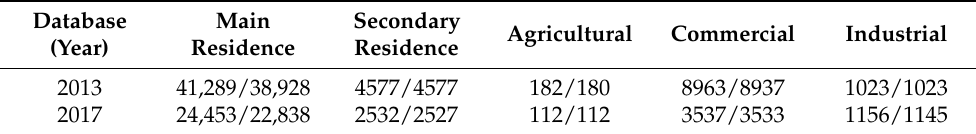
Table 3. Share of valid customers/final number of customers clustered (outliers excluded) in the two considered databases.